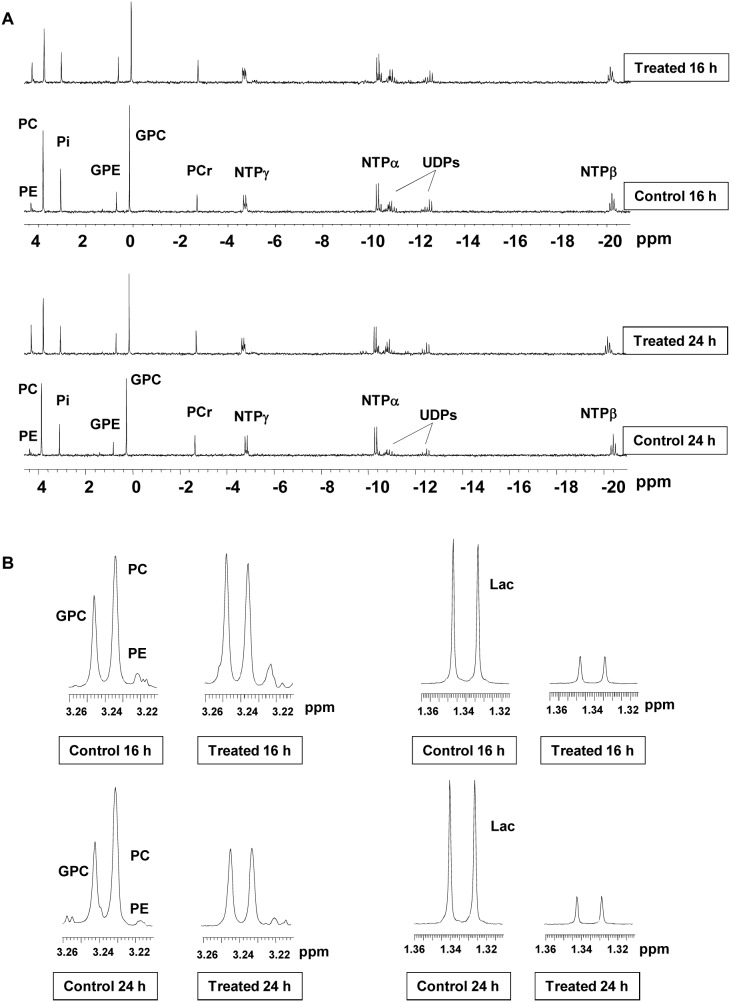
Metabolic changes following treatment of SF188 pediatric glioblastoma cells with PI-103.Representative in vitro (A) 31P-NMR spectra and (B) expansion of 1H-NMR spectra regions representing choline–containing metabolites (left) or lactate (Lac; right) of SF188 aqueous cell extracts following 16 or 24 hours treatment with PI-103 (5×GI50) compared to vehicle (DMSO) treated control. UDPs = UDP sugars.